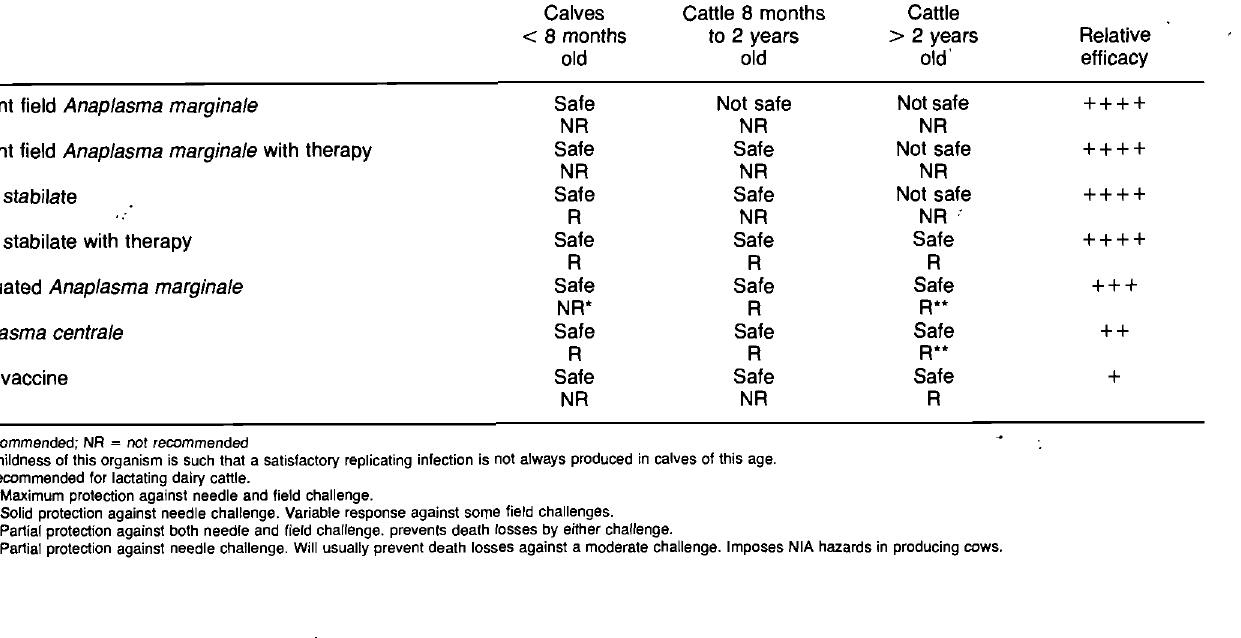
Table 7: SYSTEMS OF ANAPLASMOSIS IMMUNIZATION Calves Cattle 8 months Cattle < 8 months